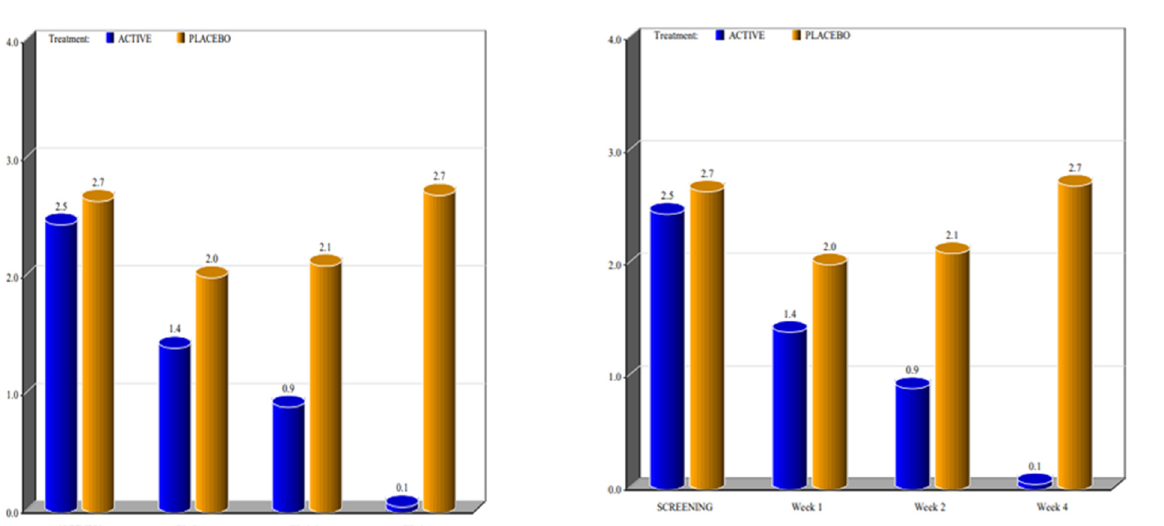
Figure 4. Mean value of pain determined with the swab test at the 5 o’clock ( left ) and 7 o’ clock ( right ) positions ( p value < 0.0001).